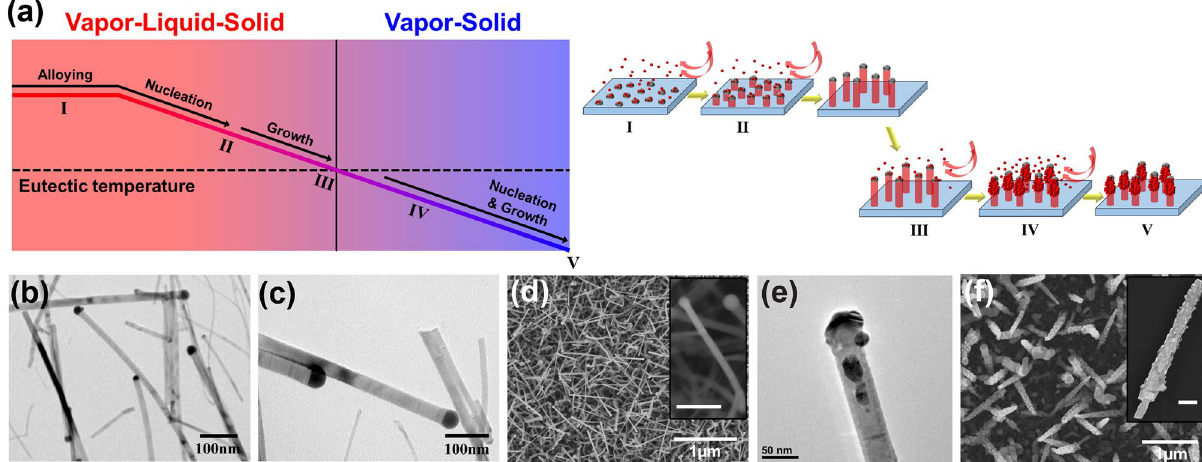
Figure 1. Hierarchically-assembled ZnS nanostructures preparation. ( a ) Schematic diagram of the hierarchically-assembled ZnS nanostructures growth mechanism. TEM images of ZnS nanowires with temperatures (II → III); ( b ) 800 °C and ( c ) 760 °C. ( d ) SEM image of ZnS nanowires at eutectic temperature (III). ( e ) Nanoparticles growth initiation (III → IV) confirmed by TEM image. ( f ) SEM image of ZnS nanostructures (V). Both insets in ( d ) and ( f ) displayed a single nanowire and nanostructure from high- magnification SEM images (scale bar: 100